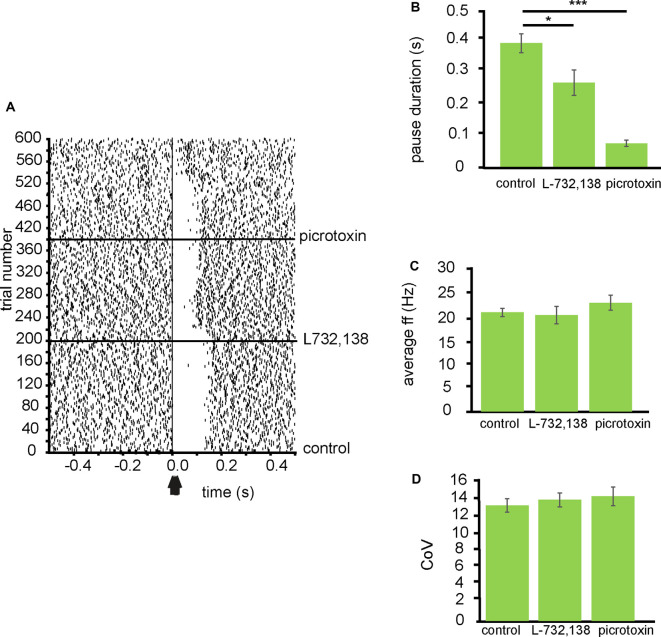
Inhibition of VP neurons by NAc stimulation is modulated by NK-1 receptors. All experiments represented in this figure used the second stimulation protocol (100 Hz) identified in the “Materials and Methods” section. (A) A typical example raster plot of tonic firing activity in a VP neuron from 0.5 s to 1.0 s post-stimulation of the NAc. The raster plot exemplifies one neuron response during 200 applications of stimulation in control conditions, 200 stimulations after the application of L732,138, and 200 stimulations after the application of picrotoxin. (B) Bar chart representing significant (*P < 0.05, ***P < 0.001) differences in the average pause duration (ms) for neurons in the VP after NAc stimulation. Each bar represents the average pause duration in different pharmacological conditions: in control conditions, in the presence of L732,138, and in the presence of picrotoxin. (C) Bar chart representing non-significant (P > 0.05) differences in the average firing frequencies for neurons in control conditions, in the presence of L732,138 and in the presence of picrotoxin. (D) Bar chart representing non-significant (P > 0.05) difference in the coefficient of variation for neurons in control conditions, in the presence of L732,138 and in the presence of picrotoxin.